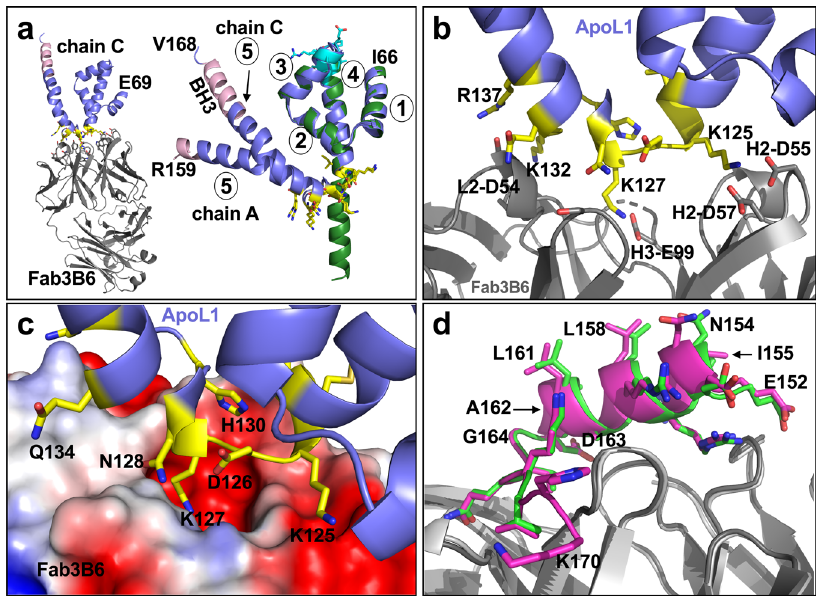
Fig. 2 Structures of ApoL1-NTD in complex with Fab3B6 and of the BH3-like region bound to Fab7D6. a Overview (left panel) of the complex of Fab3B6 (gray) with ApoL1-NTD (chain C in blue) with the N-terminal E69 indicated. The epitope region is in yellow. Right panel: the two different chains of the asymmetric unit, chain A (I66-R159) and chain C (E69-V168), are shown in blue with yellow epitope residues as sticks. Superposition with ApoL1-NTD from the Fab6D12 complex (dark green) shows that the four-helix cores (helices 1 – 4 are indicated) are virtually identical among the three structures, but they differ in that chains A and C of the Fab3B6 complex have a long, slightly bent helix 5 ending with the fully (chain C) or partially resolved (chain A) BH3-like region (in pink). b and c Close-up view of the epitope region (yellow) with the Fab as gray cartoon ( b ) or as surface ( c ), colored according to approximate net electrostatic potential (blue, positive; red, negative). The paratope surface is predominantly acidic, due to four acidic residues L2-D54, H2- D55, H2-D57, and H3-E99, which all engage in interactions with at least one of the four basic epitope residues K125, K127, K132, and R137. d The BH3-like region from the Fab7D6 co-crystal structures. Overlay of the BH3-like region from the Fab7D6:ApoL1-peptide complex (Fab in light gray, BH3 peptide in green) with that of the Fab7D6:ApoL1-NTD swapped dimer complex (Fab in dark gray; BH3-like region in magenta). The structures superimpose well, with the hydrophobic face of the amphipathic BH3-like helix pointing away from the Fab binding